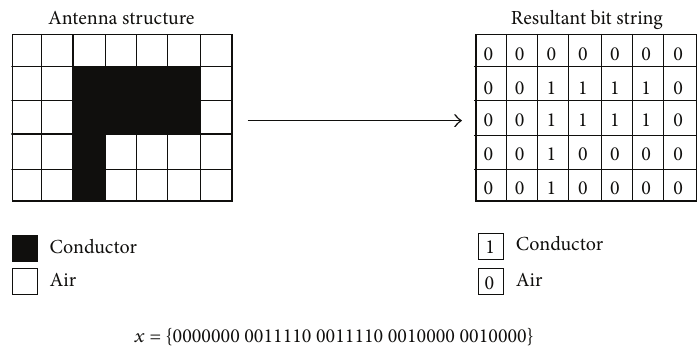
Figure 1: The relationship between the physical antenna structure and the resultant bit